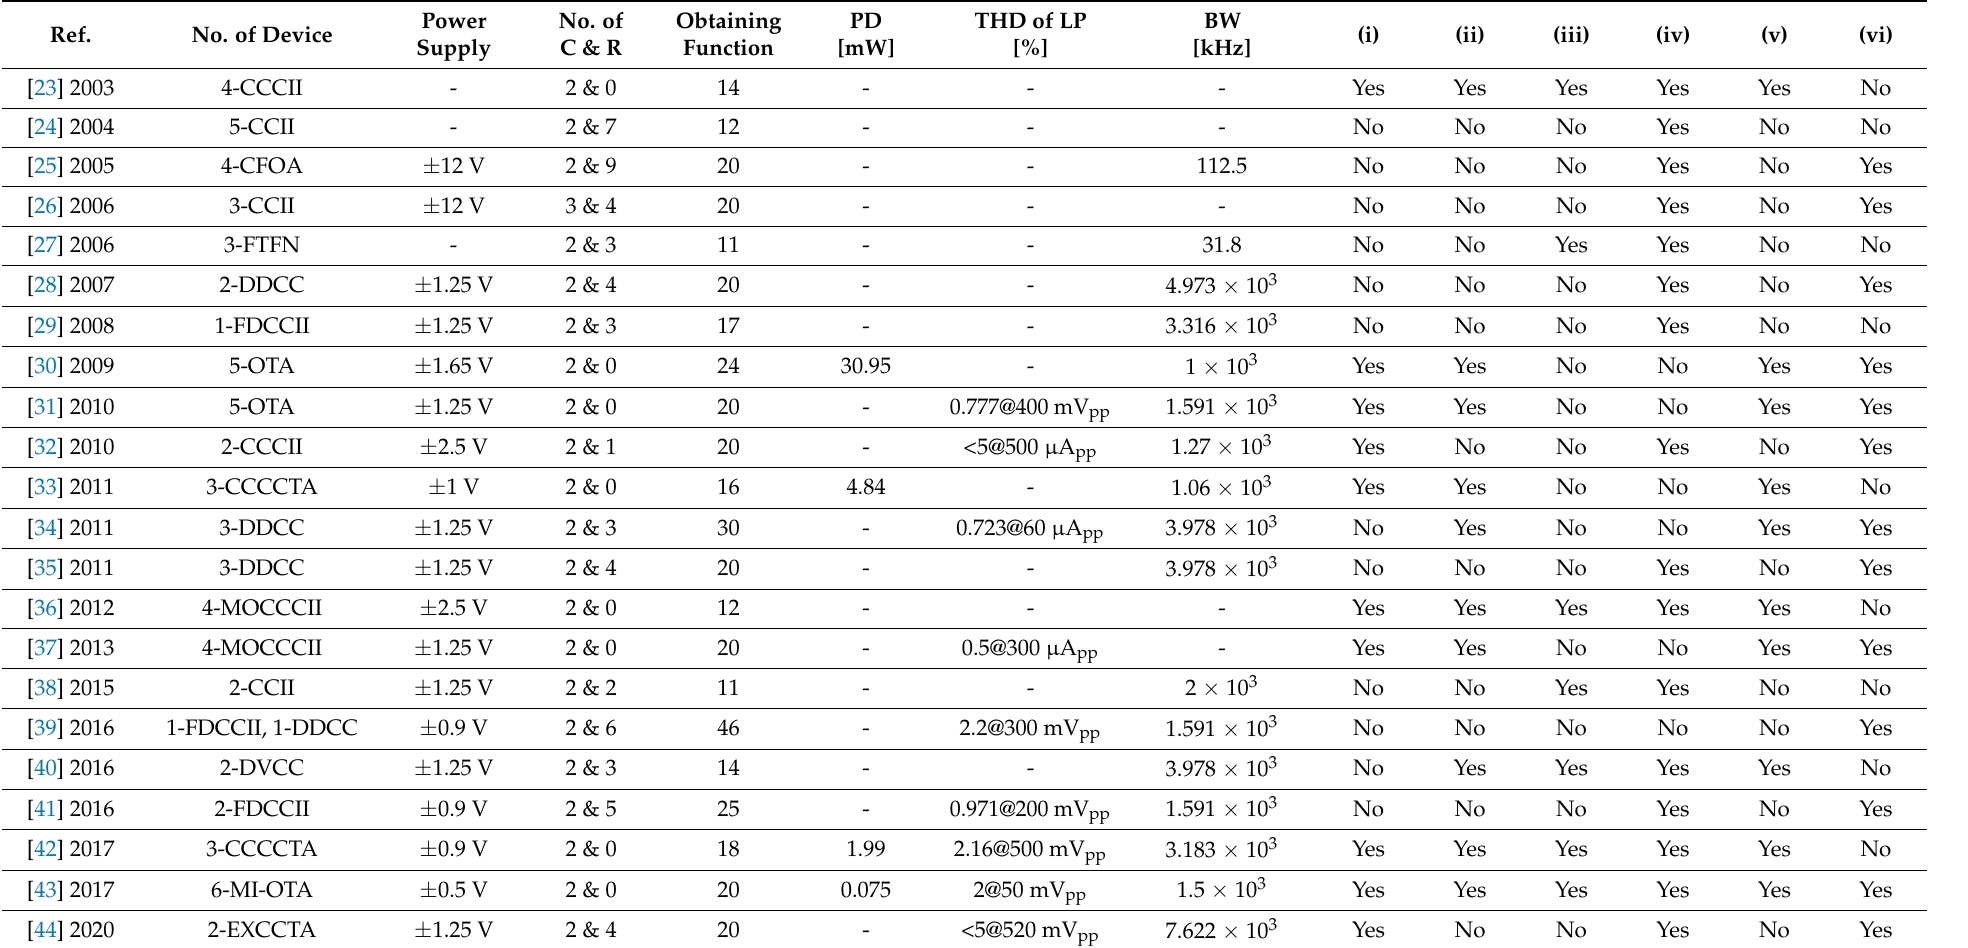
Table 1. Comparison the proposed filter with the previous mixed-mode universal filter.